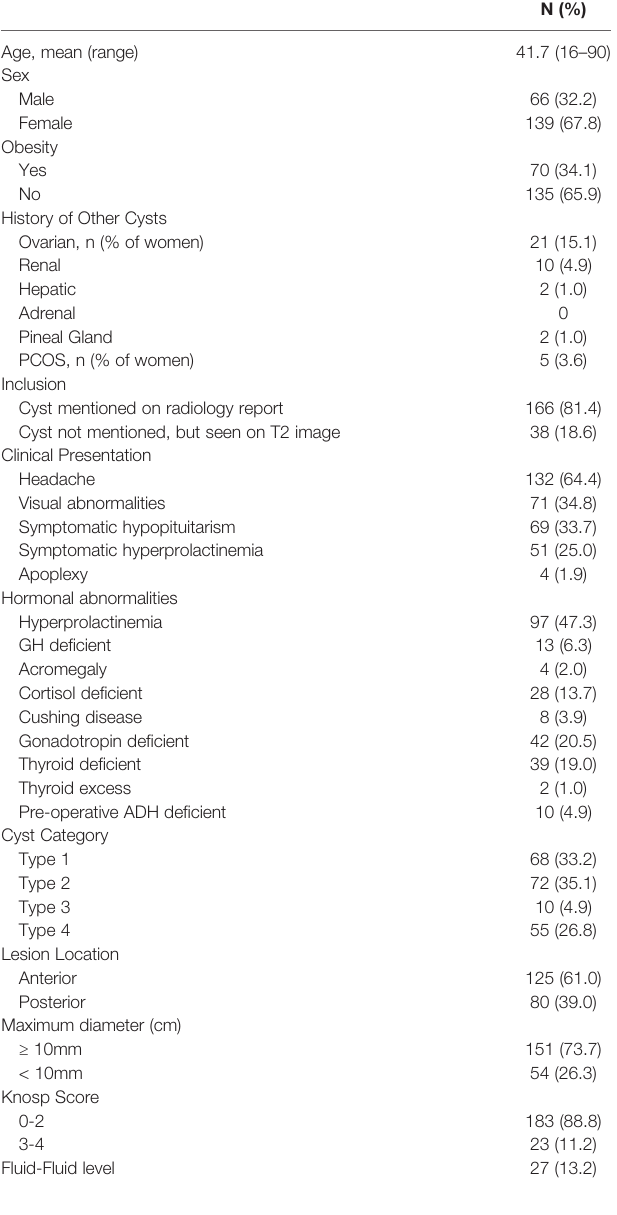
TABLE 1 | Preoperative patient/lesion characteristics, including patient demographic data, tumor symptoms, serum hormone levels, and radiographic features.